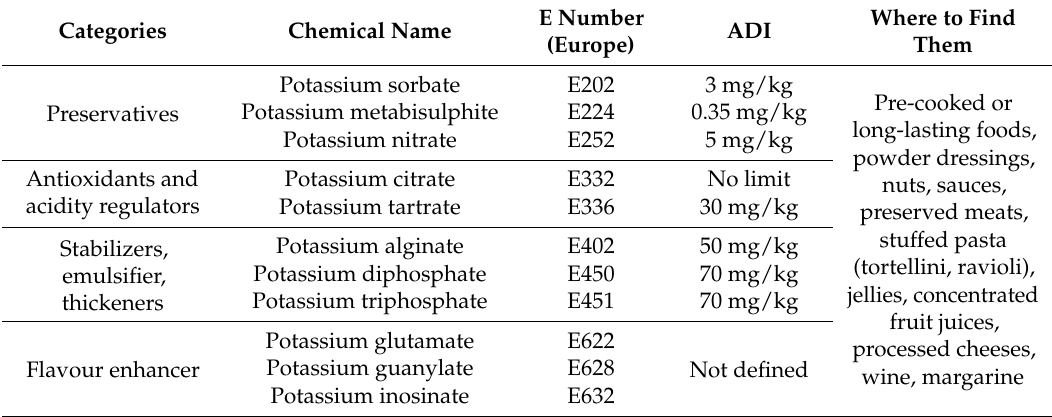
Table 5. Most frequently used potassium-based food additives and the corresponding acceptable daily intake